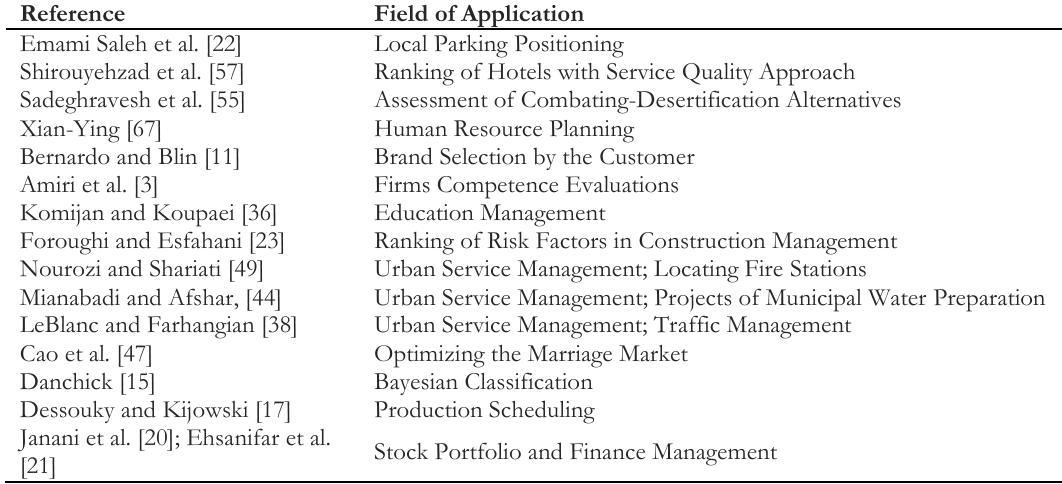
Table 1. Some applications of